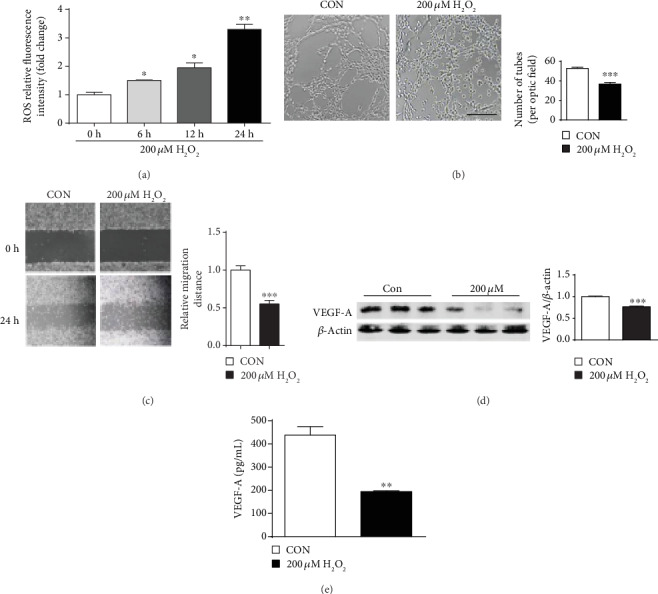
Oxidative stress induced by H2O2 inhibited tube formation and migration in porcine vascular endothelial cells (PVECs). (a) ROS generation in PVECs treated with 200 μM H2O2 for 6, 12, and 24 h. n = 3. (b) Representative images of tube formation by PVEC cells, treated with 200 μM H2O2 for 24 h (right) or in standard medium (left). Cells were seeded at a density of 4 × 104 cells/well on a plate precoated with Matrigel and cultured for 6 h. n = 5. (c) Representative micrographs of wound healing experiments. PVEC cells were maintained for 24 h in basal medium (left) or treated with 200 μM H2O2 (right). n = 3. (d) VEGF-A protein levels were detected by Western blotting in cells after treatment with 200 μM H2O2 for 24 h. VEGF-A protein levels were detected by Western blotting after cells under treatment with 200 μM H2O2 for 24 h. n = 3. (e) VEGF-A levels were measured by ELISA in the culture medium of cells under treatment with 200 μM H2O2 for 24 h. n = 5. Data are presented as mean ± SEM. The differences between the two groups were analyzed by Student's t-test. All experiments were performed in triplicate. ∗P < 0.05; ∗∗P < 0.01; ∗∗∗P < 0.001.